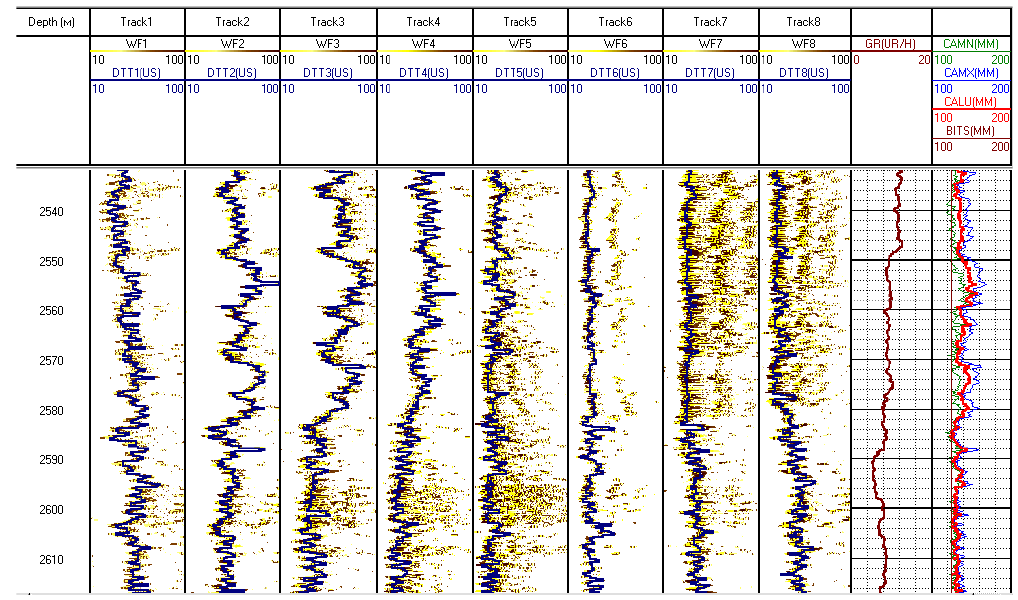
Figure 4. Data processing results.